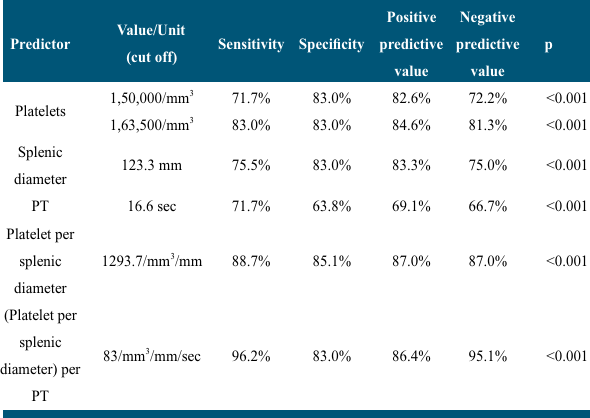
Table 6: Sensitivity, specicity, positive & negative predictive values and p values of different non- invasive predictors of varices at cut off values